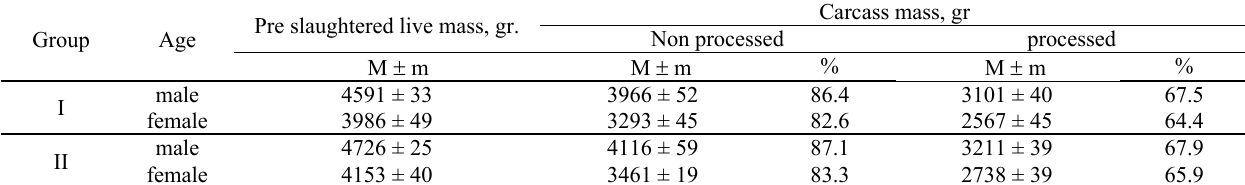
The results of the slaughter of geese in experimental groups at 9 weeks of age, (М  m) n = 3 Pre slaughtered live mass, Group Age